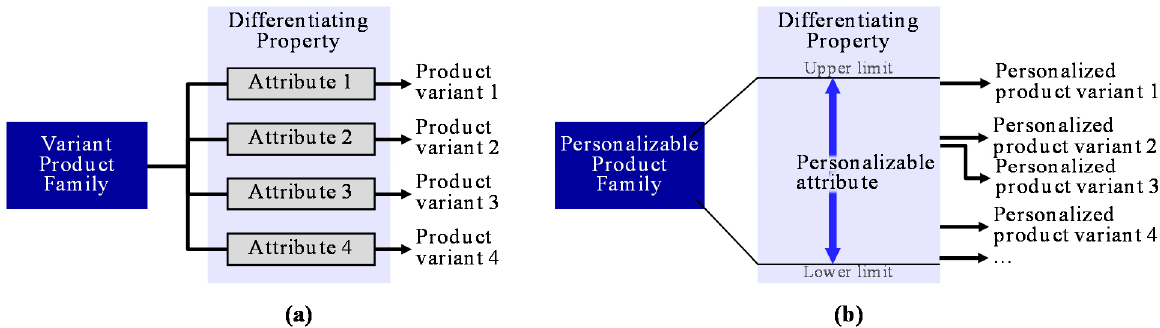
Figure 1. ( a ) Predefined, discrete attributes of a variant product family compared to ( b ) a personalizable product family with personalized attribute.